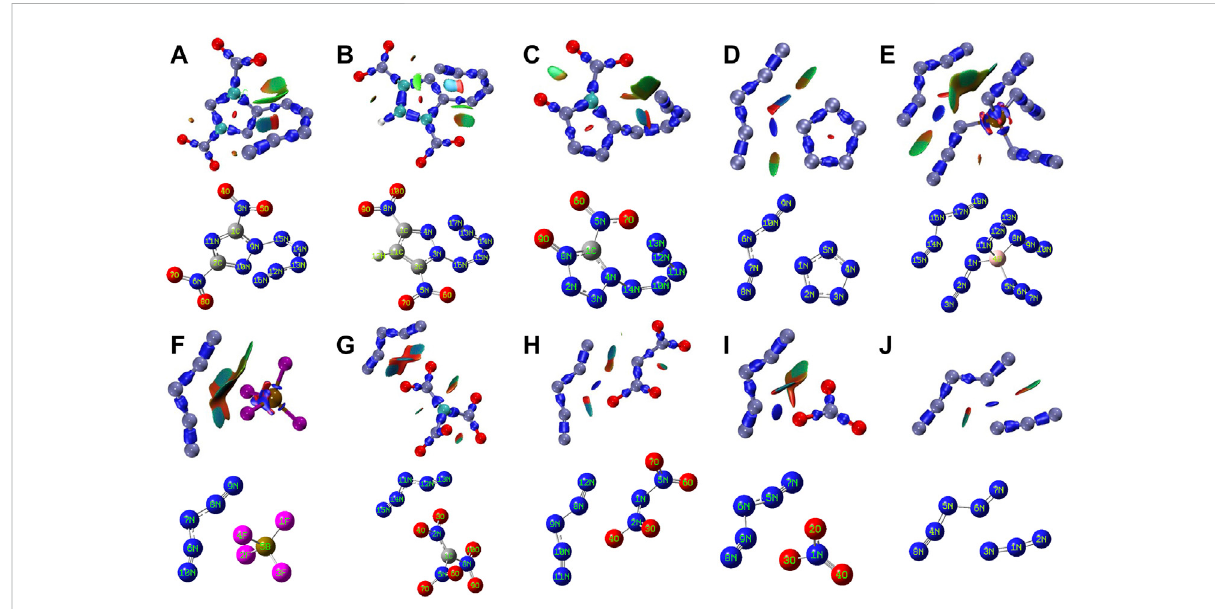
FIGURE 6 Isosurface map of IRI and molecular structures of N 5 + salts in this